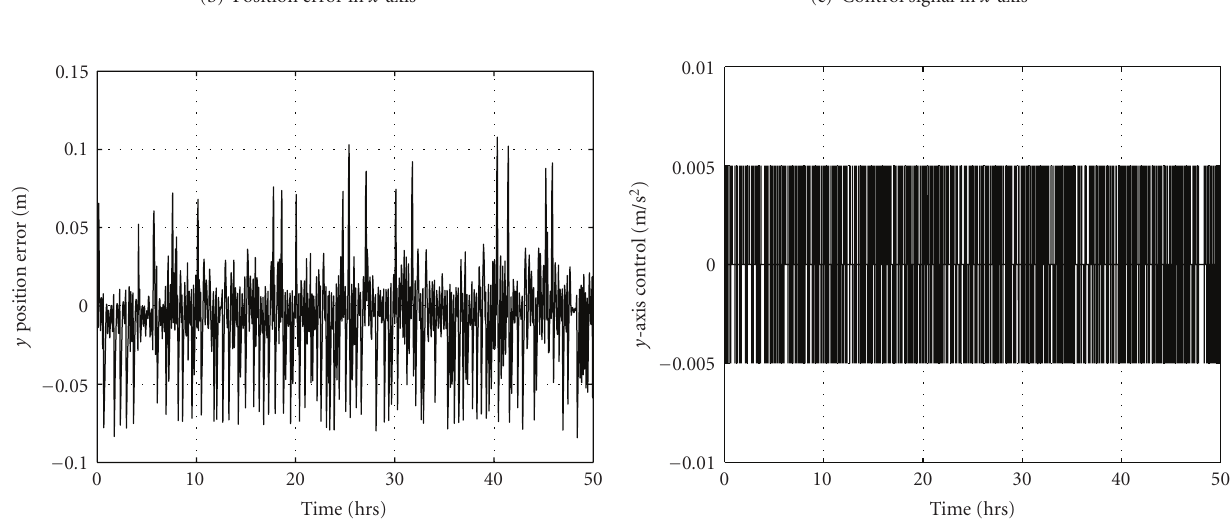
(e) Control signal in y -axis